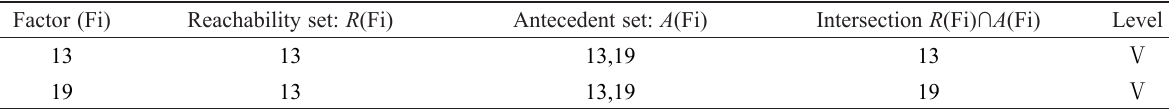
Table 8. Last iteration (5th) of Reachability Matrix